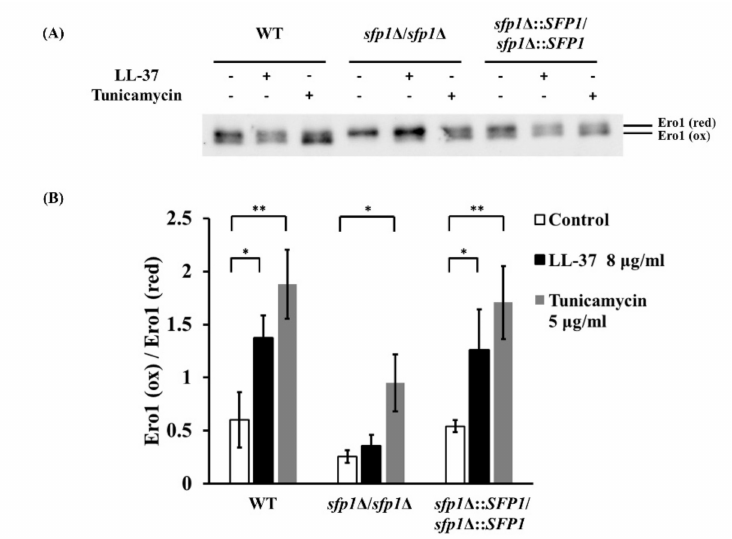
Figure 6. Effect of LL-37 and deletion of SFP1 on the redox state of Ero1. ( A ) After treatment with LL-37 or tunicamycin for 30 min, total proteins were harvested. The proteins were resolved by nonreducing 6% SDS–PAGE. Western blotting was performed to detect Ero1-Flag using an anti-Flag antibody. ( B ) The ratio of Ero1(ox)/Ero1(red) was obtained by analysis using ImageJ software. The results are expressed as the mean ± SD of three independent assays. * p < 0.05; ** p <